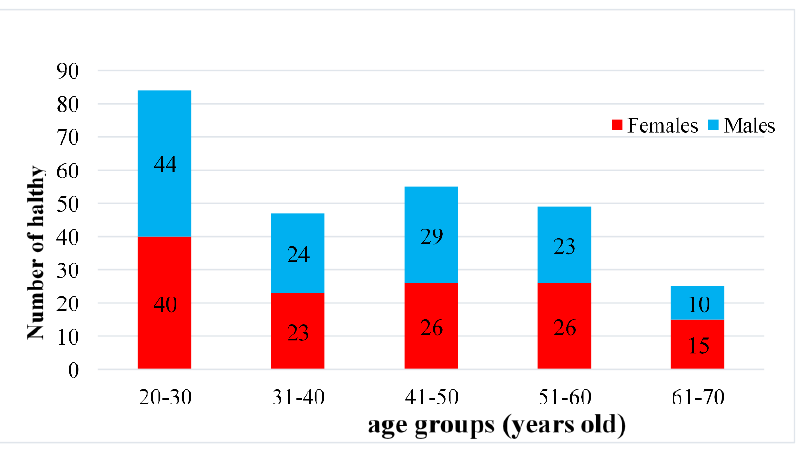
Figure 1. Number of healthy participants of the Taiwan normative database.